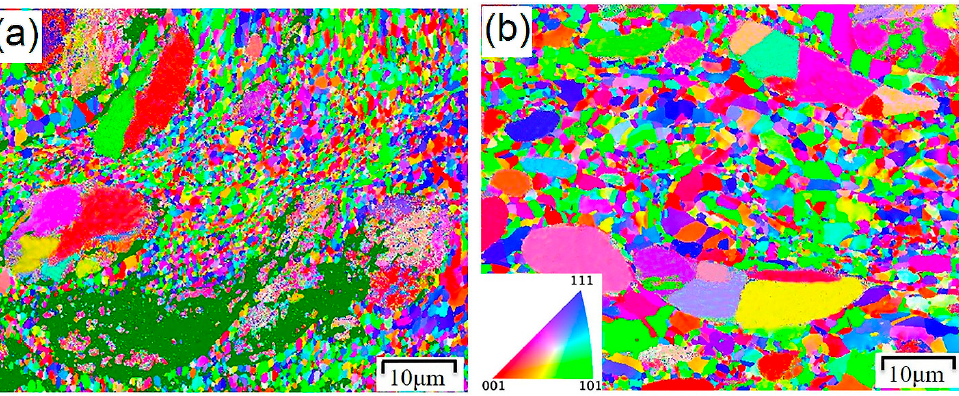
Figure 11. EBSD image of CSAM-ed Ni/FeSiAl before and after HT. ( a ) As-sprayed condition and ( b ) annealed condition. Reprinted with permission from Ref. [310], Elsevier,